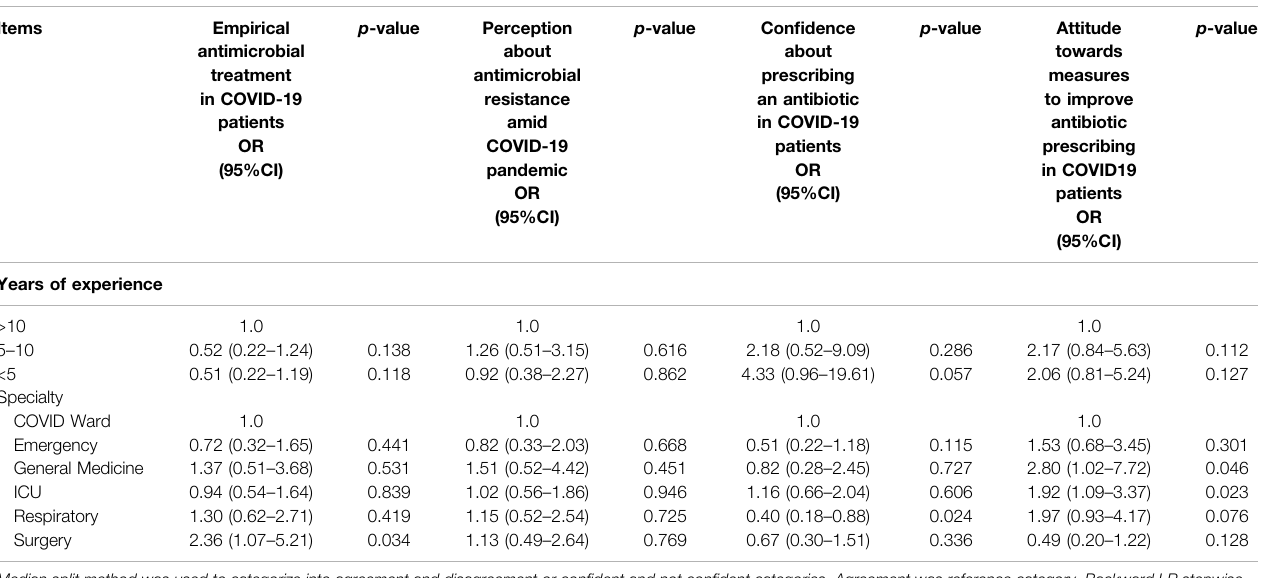
Frontiers in Pharmacology |